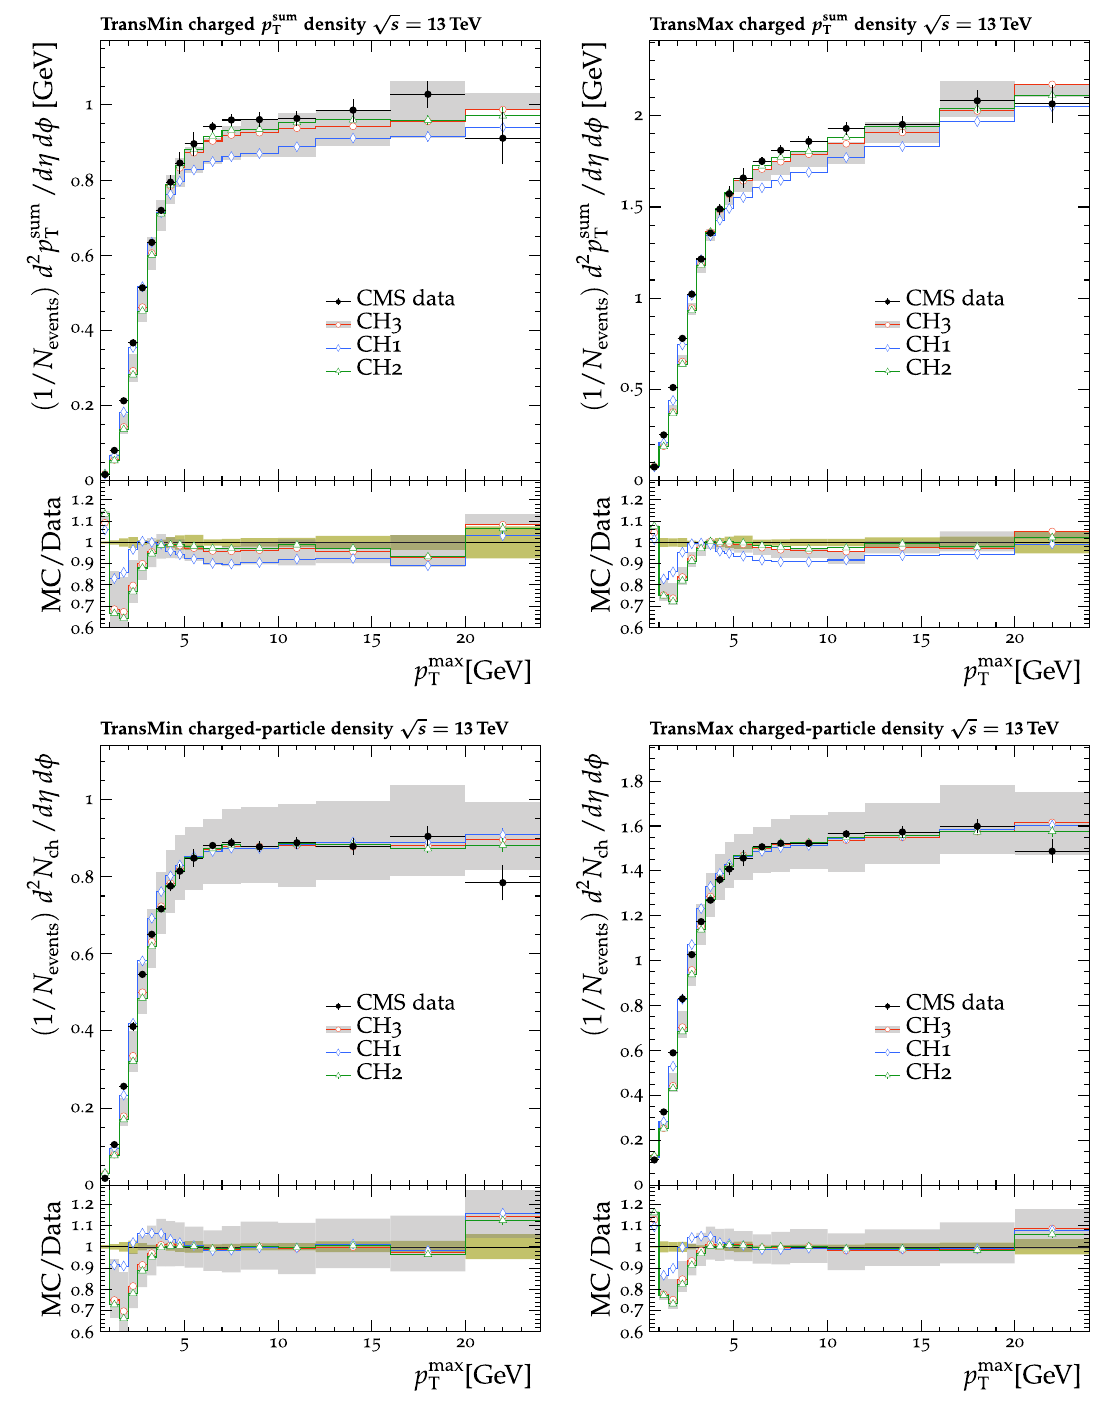
Fig. 9 The p sum (upper) and N ch (lower) density distributions in the T transMin (left) and transMax (right) regions, as a function of the p T of the leading track, p max [24]. CMS MB data are compared with the T predictions from herwig 7, with the CH tunes. The coloured band in